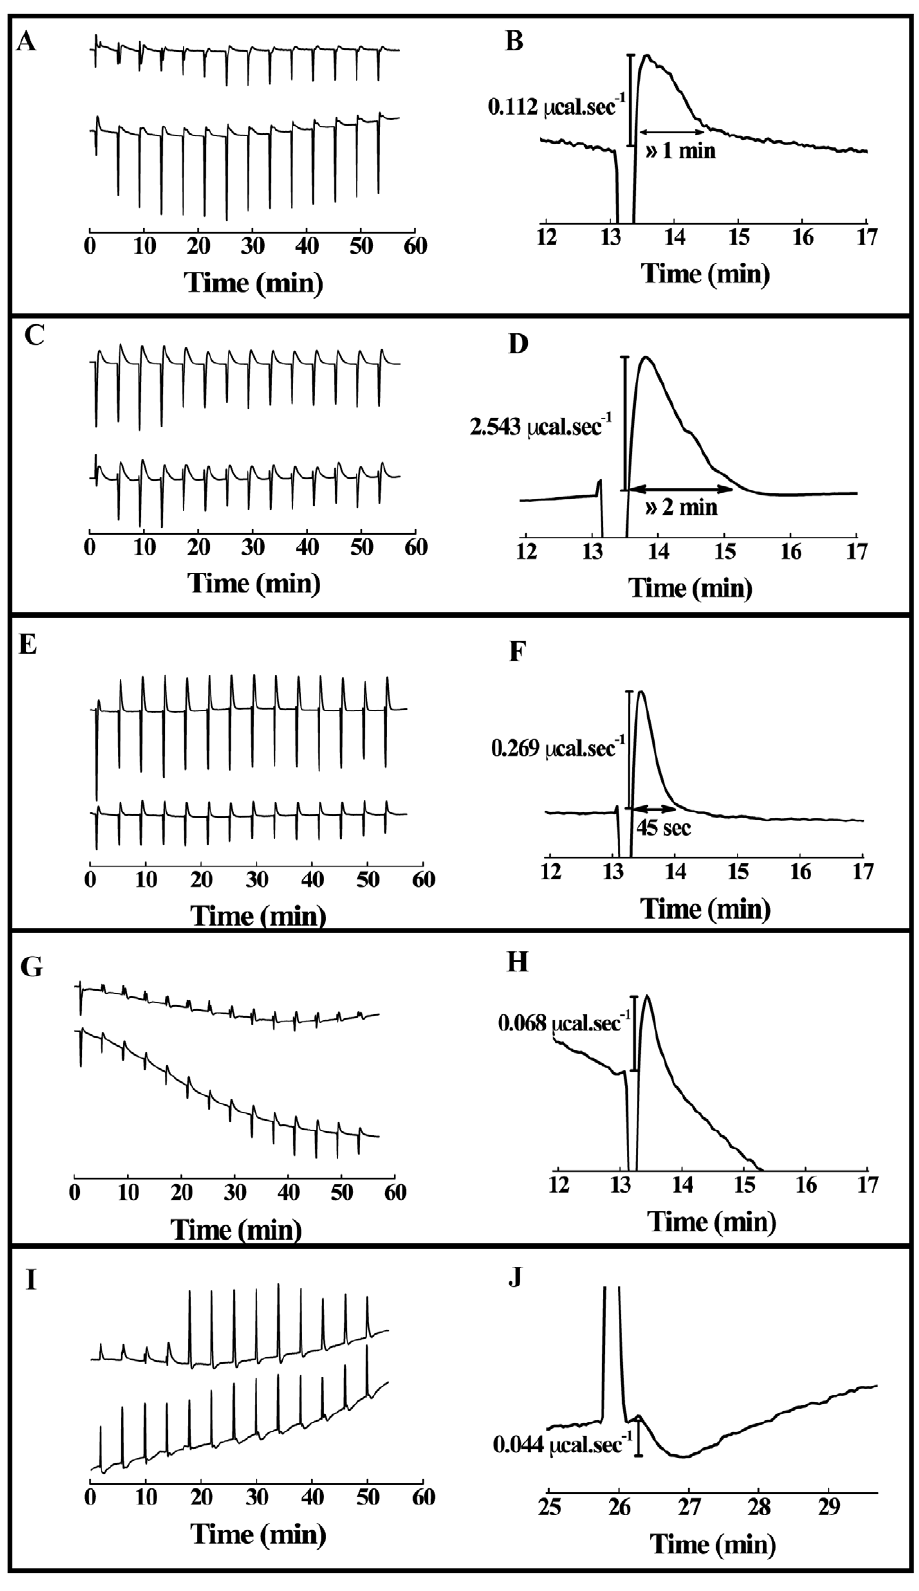
Figure 6. Binding of wtEBO 16 and W8A to lipid membranes by isothermal titration calorimetry. Each peak corresponds to a 5 m L injection of vesicles into the sample cell containing a 100 m M solution of wtEBO 16 (a) or W8A (b) peptide. (A) PC LUVs, (C) PC:PE:PI:Cho LUVs (2:1:0.5:1), (E) PC:PE:SPM:Cho LUVs (1:1:1:1.5) LUVs, (G) lipid rafts from BHK-21 cells and (I) lipid rafts from VERO cells. (B), (D), (F), (H) and (J) are enlarged views of